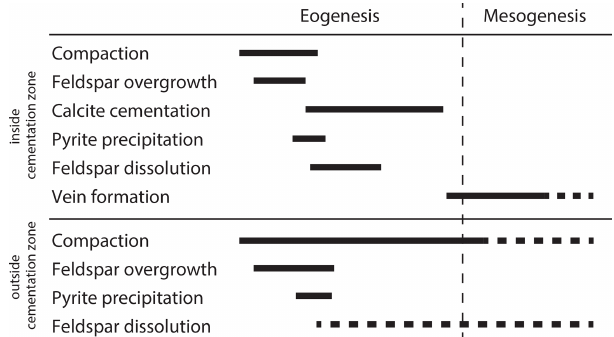
Figure 6. Paragenetic sequence of the main diagenetic events in the Lindemans Bugt Formation.